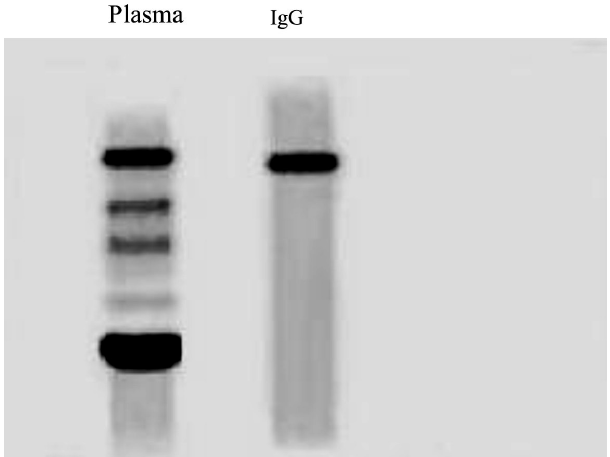
FIGURE 3 - Electrophoresis of fresh plasma sample (left) and of the finished product (IgG